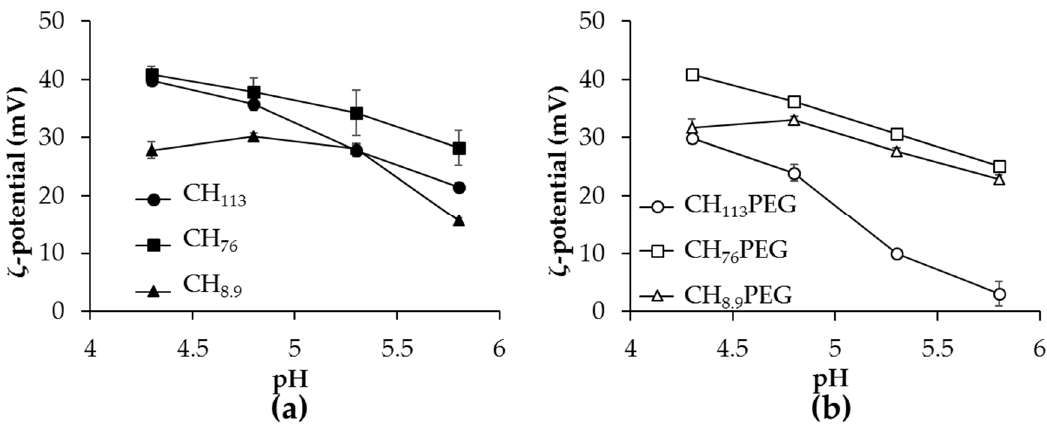
Figure 2. Effect of pH on the ζ -potential of heated α -lac mixtures ( r = 10) with ( a ) CH XX and ( b ) CH XX PEG.